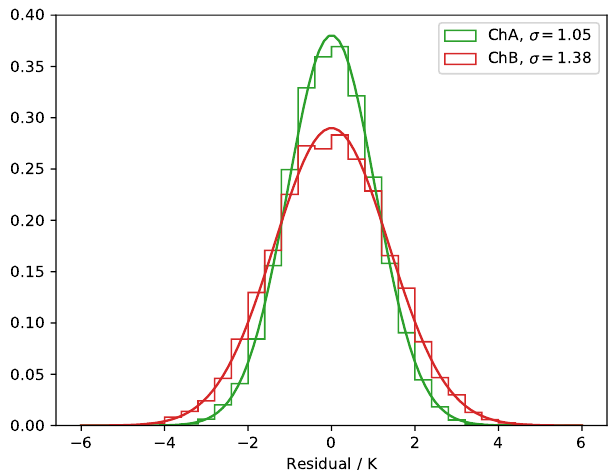
Figure 5. Histogram of the residuals for the different spectra (ChA only, ChB only, and combined) with the normal distribution corresponding to the data mean and standard deviation. Vertical gray lines indicate boundaries of individual sub-spectra. Measurements are annotated with tropospheric opacity τ .